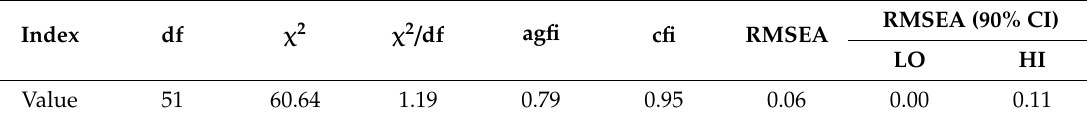
Figure A5. The 3-scale structure model graph yielded by the CFA of the indicator of “system usability” Table A9. Structure-model fit indices of the indicator of “system usability” yielded by the CFA process a.